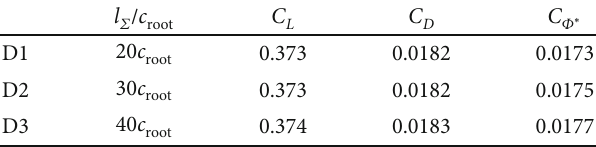
Table 4: Domain size study